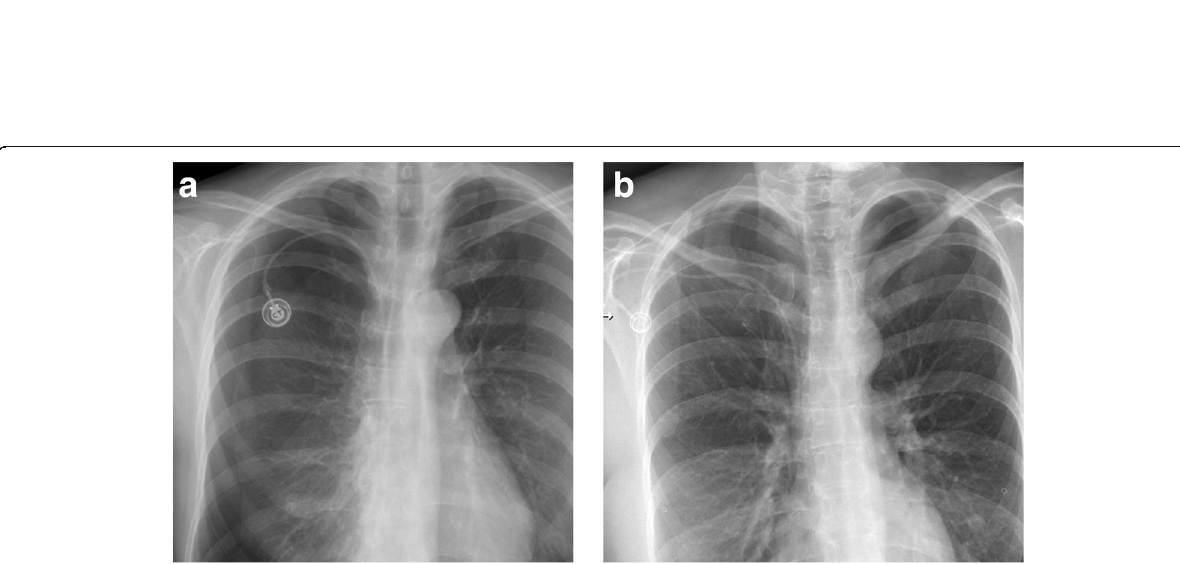
Fig. 7 Pneumothorax. a Three days after correct placement of port system, the patient complained of dyspnea. Chest radiograph shows a large right pneumothorax. b Regular placement of a port system on the right side. There is a contralateral pneumothorax from unsuccessful attempts on the left side, which were not mentioned in the referral